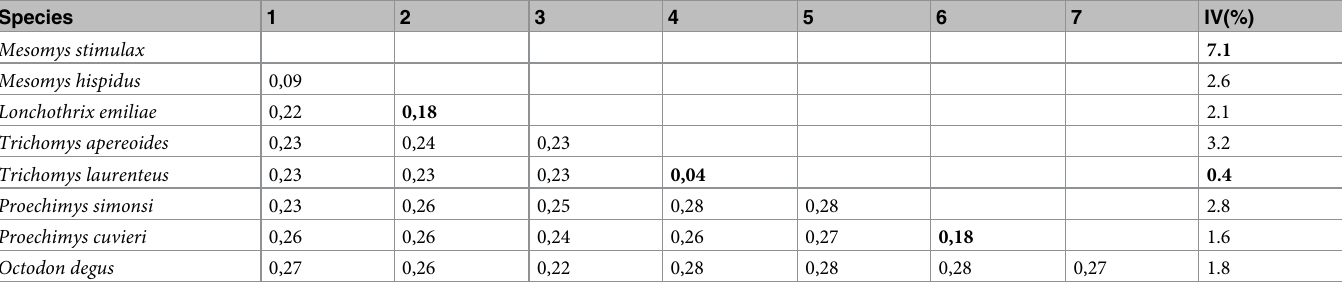
Table 2. P -distance estimates for the Cytochrome b ( Cytb ) gene among the monophyletic clades recovered in the phylogenetic analysis. IV = intraspecific variation. Bold scores represent the lowest and highest values of interspecific and intraspecific divergence for the different species analyzed.